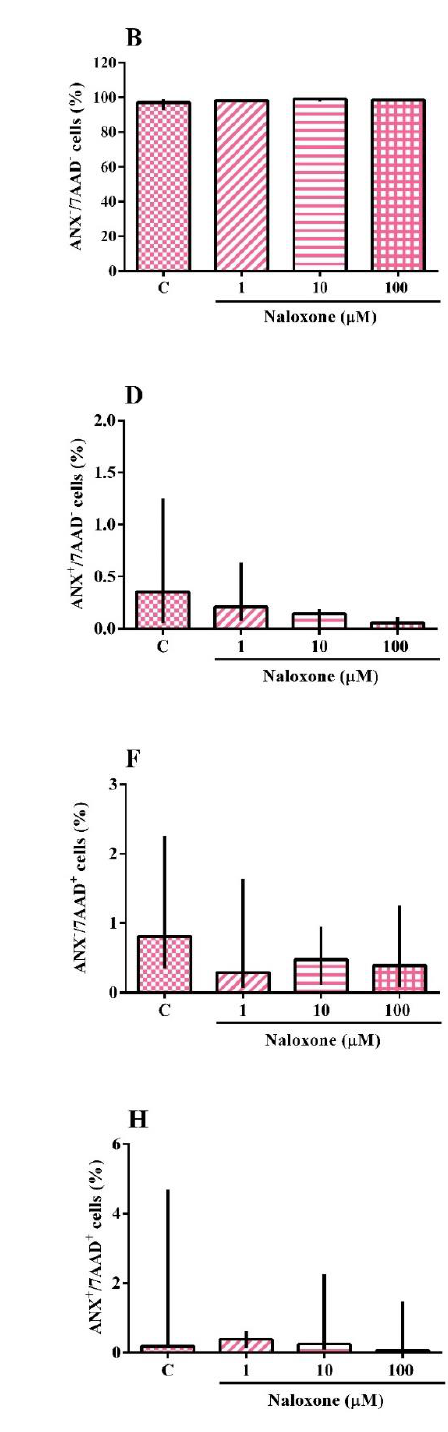
Figure 2. Identification of cell death by necrosis and apoptosis of a neuroblastoma cell line (SH-SY5Y) exposed for 24 h to oxycodone and naloxone. Viable cells (ANX − /7AAD − ) ( A , B ), apoptotic cells (ANX + /7AAD − ) ( C , D ), necrotic cells (ANX − /7AAD + ) ( E , F ), and late apoptotic and/or necrotic cells (ANX + /7AAD + ) ( G , H ). The results were analyzed by the Kruskal–Wallis test followed by Dunn’s post-test and presented as median ± interquartile interval ( n = 3 – 5). C: control, nonexposed cells.